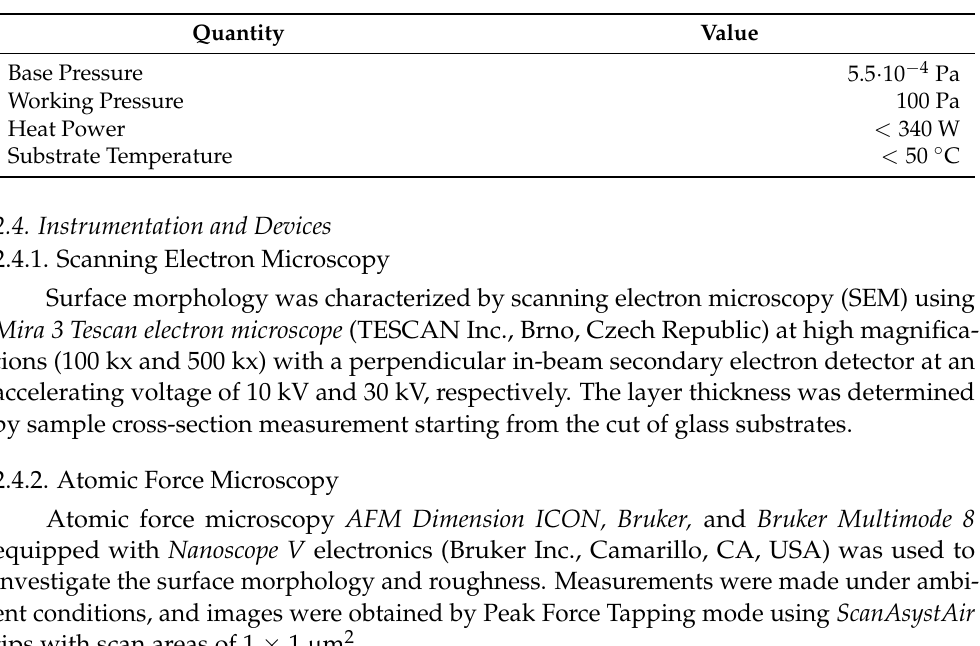
Table 1. Deposition conditions of